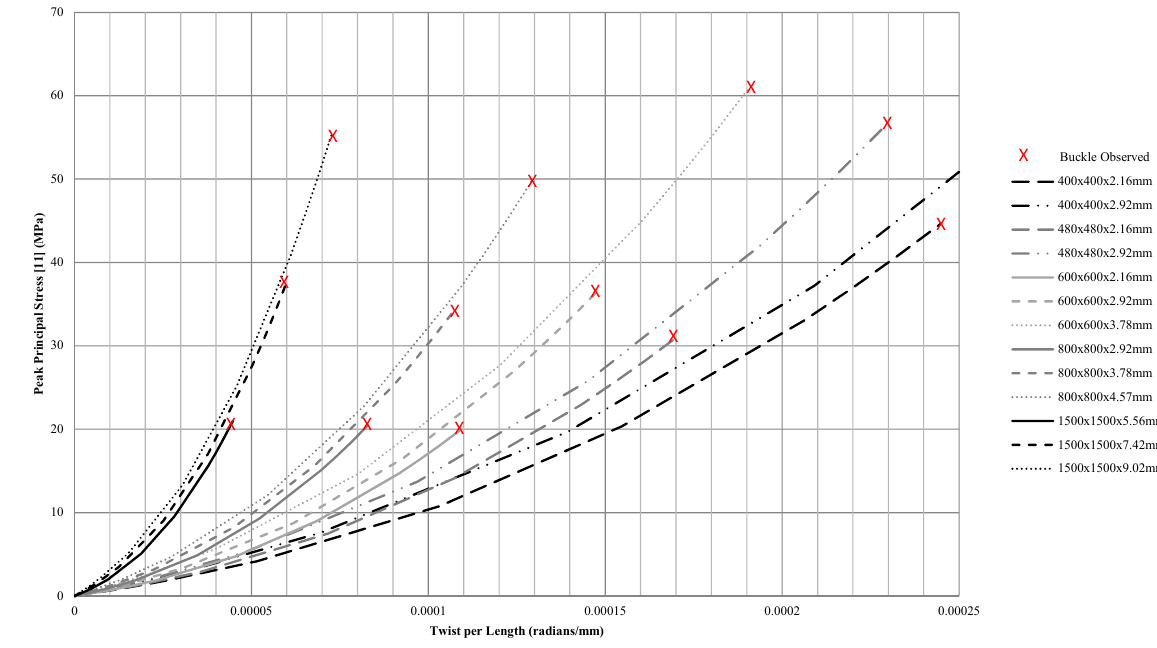
Fig. 12 Plate Stresses and Buckling from Twisting without Transverse Load (1:1